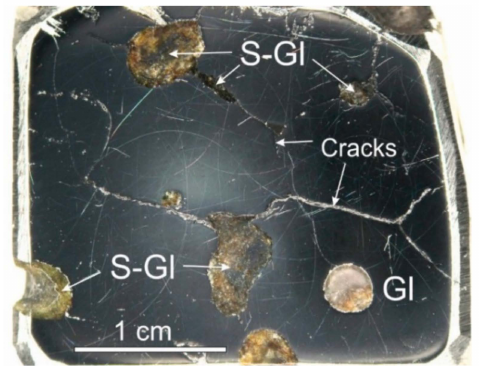
Figure 1. Example of a polished fragment of Elga IIE iron meteorite. S-GL—silicate + glass inclusions, Gl—felsic glass